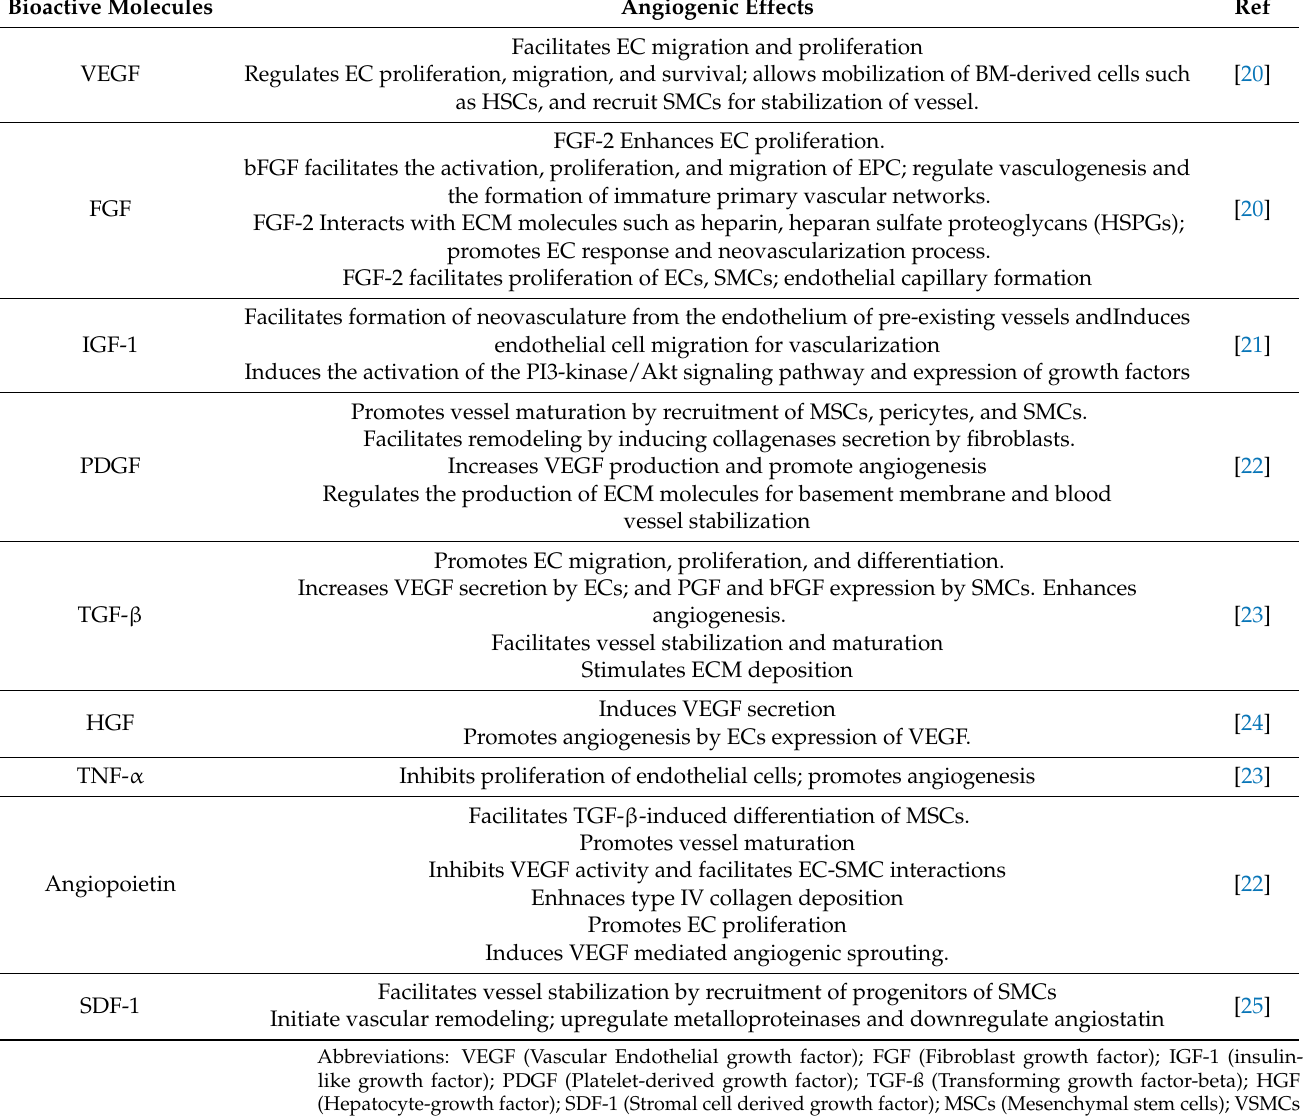
Table 1. Bioactive molecules and their effects on vascularization of tissue engineered constructs. Bioactive Molecules Angiogenic